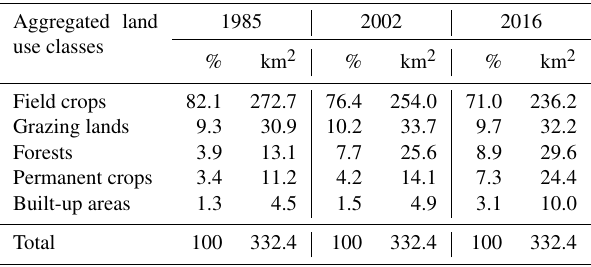
Table 1. The five major land use and management classes studied in the Wadi Beja watershed, Tunisia.